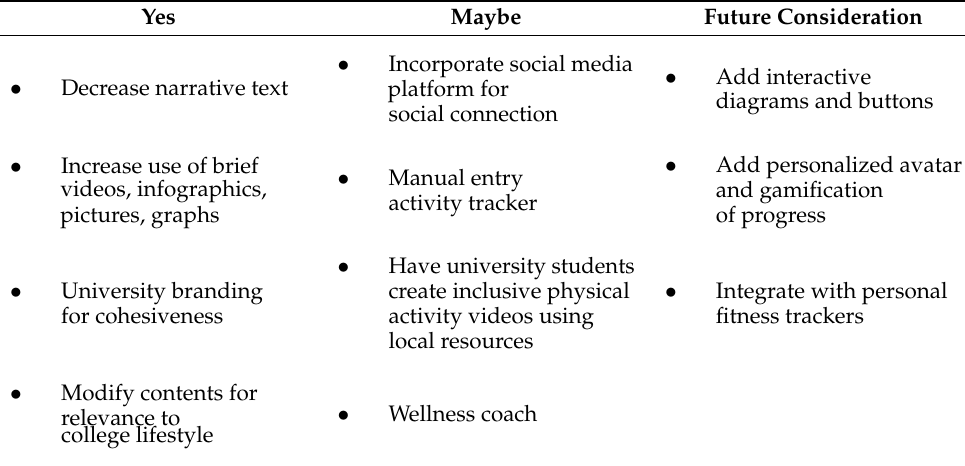
Table 2. Step 4 prioritization of implementation